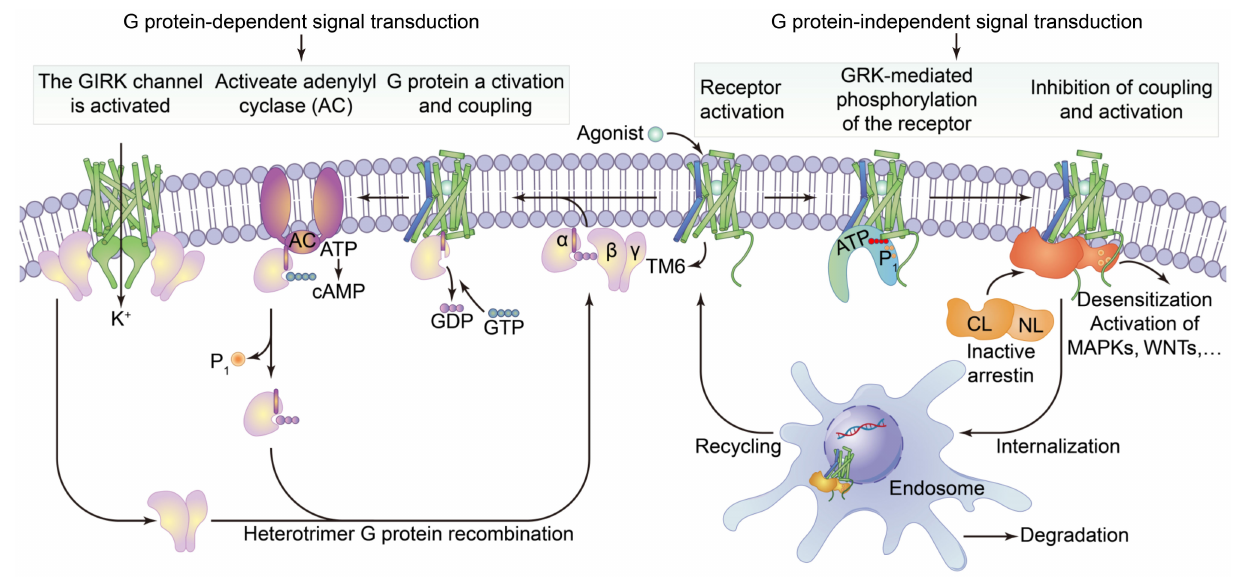
Figure 3. The structure of G protein-coupled receptors and downstream signal transduction pathways. It shows that the agonist binds to activate the receptor by inducing a conformational change in the transmembrane domain (TM6, blue). The activated receptor binds to a variety of intracellular signaling proteins, including G proteins (light purple), and GRKs (light orange), that are active (yellow) and inactive (dark orange). The coupling of heterotrimer G proteins to the receptor initiates nucleotide exchange, and then the G proteins dissociate into the G α , G β and G γ subunits. Both subunits regulate different downstream effector proteins. The GTP-bound G α subunit regulates the activity of adenylate cyclase (AC, dark purple), whilst the G β and γ subunits interact with the g-protein-coupled internal rectifying potassium channel (GIRK, represented by cylindrical TM, green). The G protein-mediated signaling pathway is terminated by GTP hydrolysis and the recombination of G α with G β and γ to form inactive heterotrimers. Activation of the receptor also leads to phosphorylation of GRKs and subsequent coupling of statin. Statin-coupled receptors lead to desensitization and statin-mediated activation of downstream effector proteins, such as mitogen-activated protein kinases (MAPKs) or SRC kinases. Statin activation also promotes receptor internalization into the endosome and subsequent degradation or circulation into the plasma